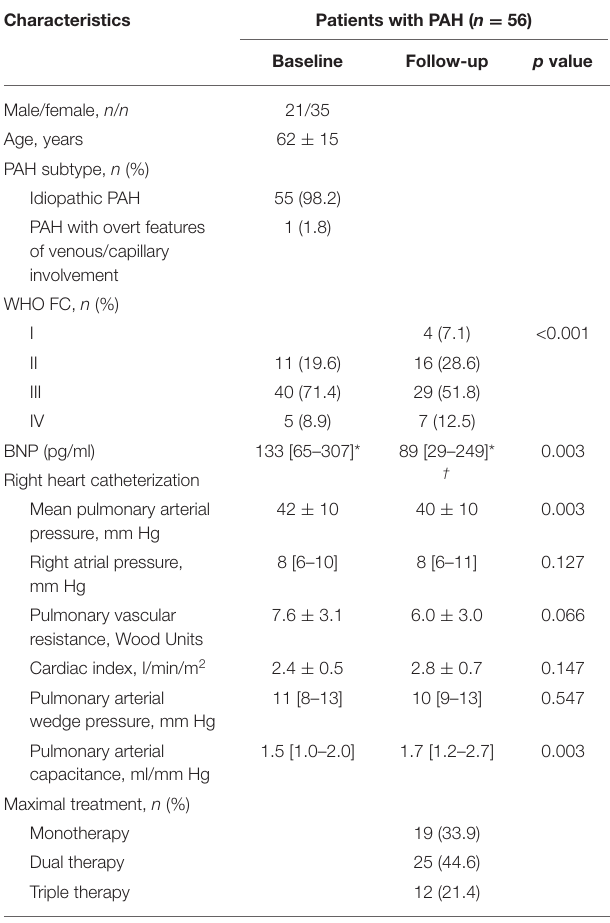
TABLE 1 | Characteristics of the